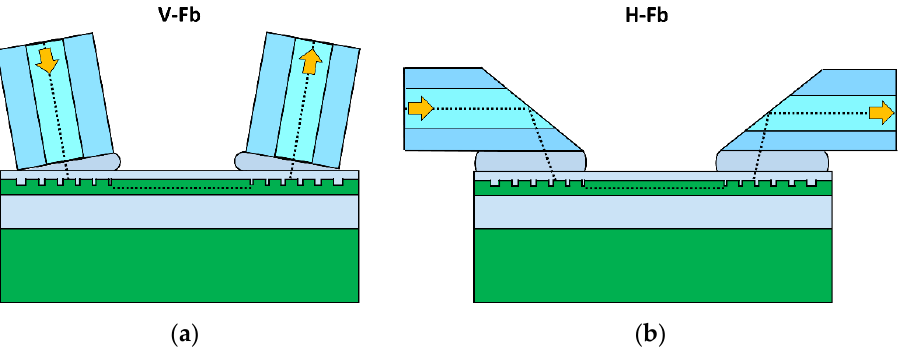
Figure 9. Light coupling geometries for ( a ) left panel, V-Fb, the vertical fiber scheme; ( b ) right panel, H-Fb, the horizontal fiber scheme.